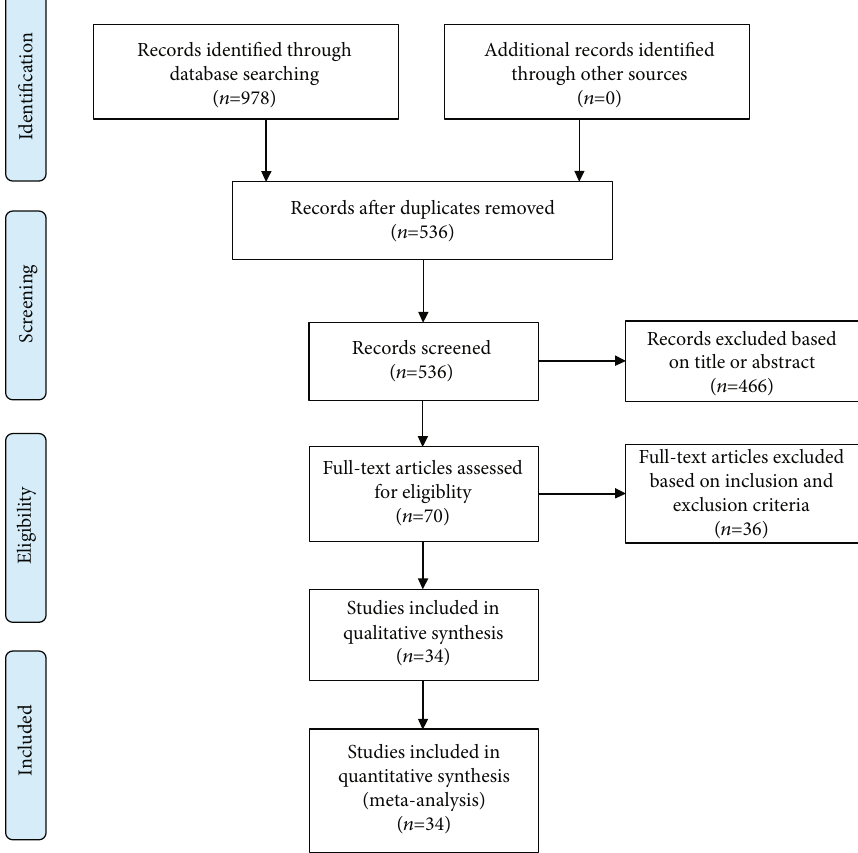
Figure 1: Flow chart of literature